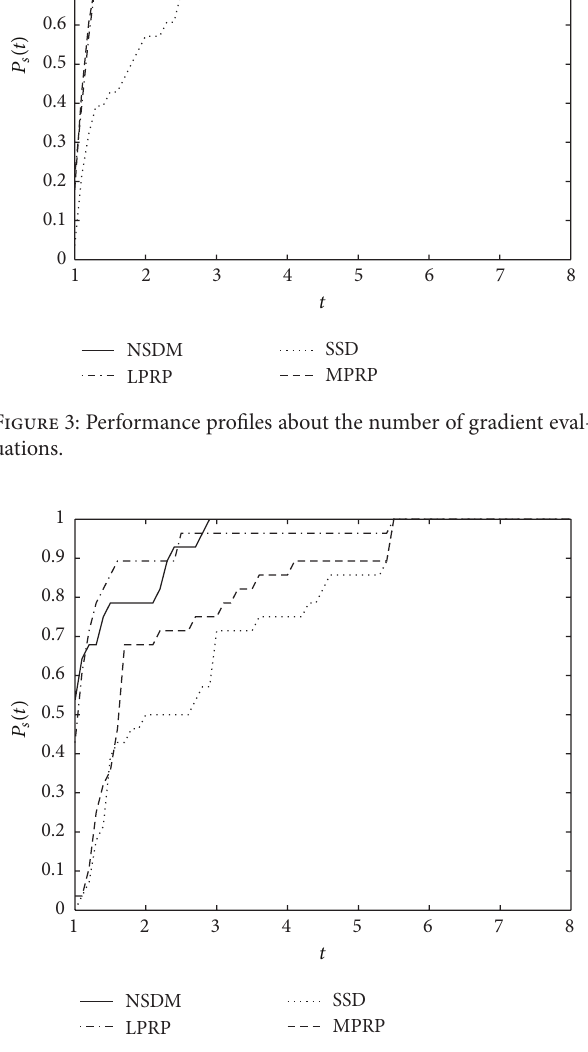
Figure 4: Performance profiles about CPU